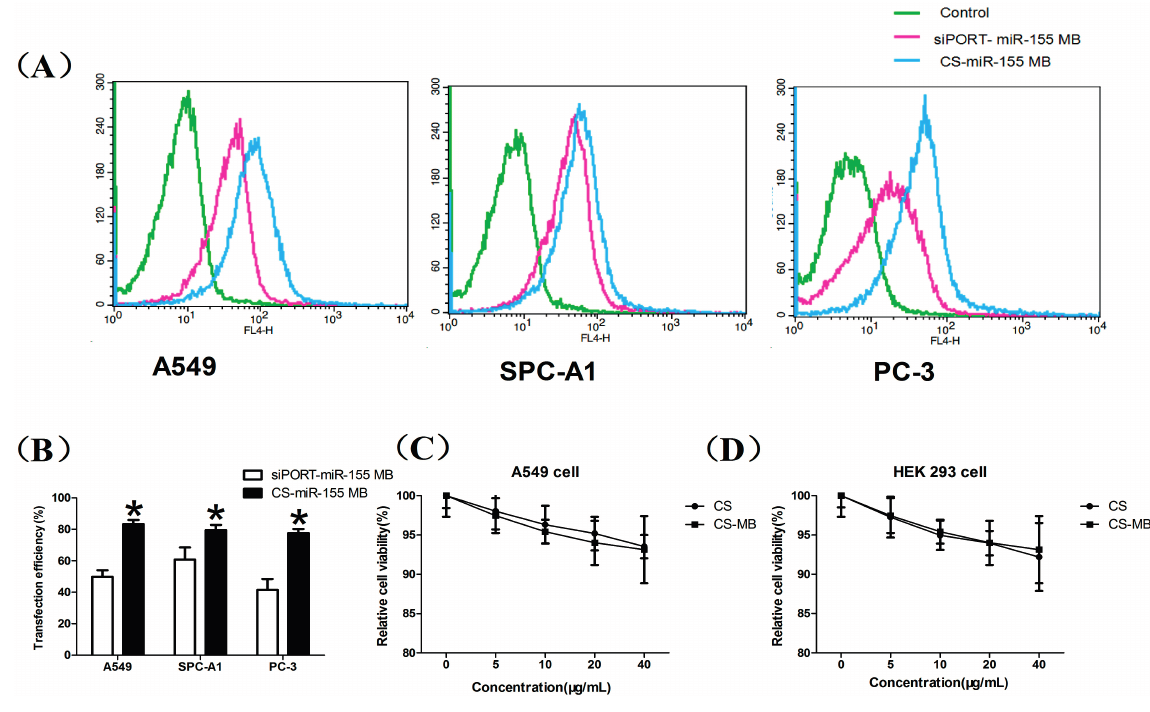
Figure 4. Flow cytometry analysis and cytotoxicity of CS and CS-MB. ( A , B ) Graphs by flow cytometry analysis and transfection efficiency of the three cell lines transfected with siPORT-miR-155 MB and CS-miR-155 MB (n = 3). * p < 0.05. ( C , D ) Cytotoxicity of CS and CS-MB to A549 cells and HEK 293 cells (n =